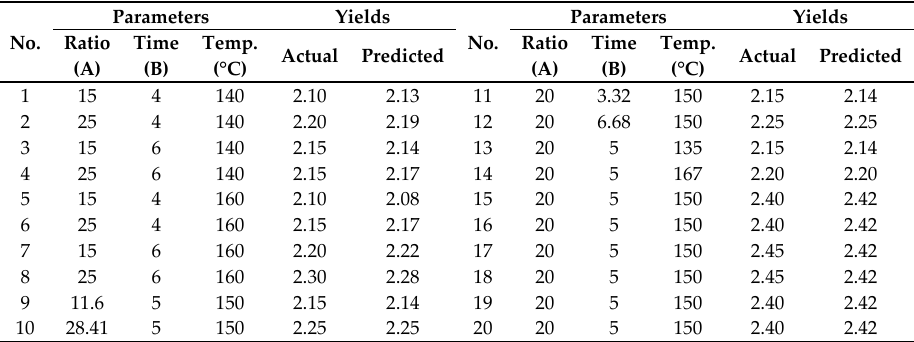
Table 1. Details of experimental attempts employed in the response surface methodology (RSM) optimization.